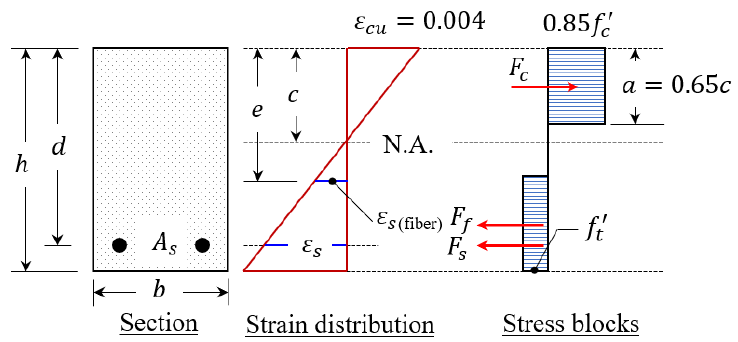
Figure 5. Strain and stress profiles.